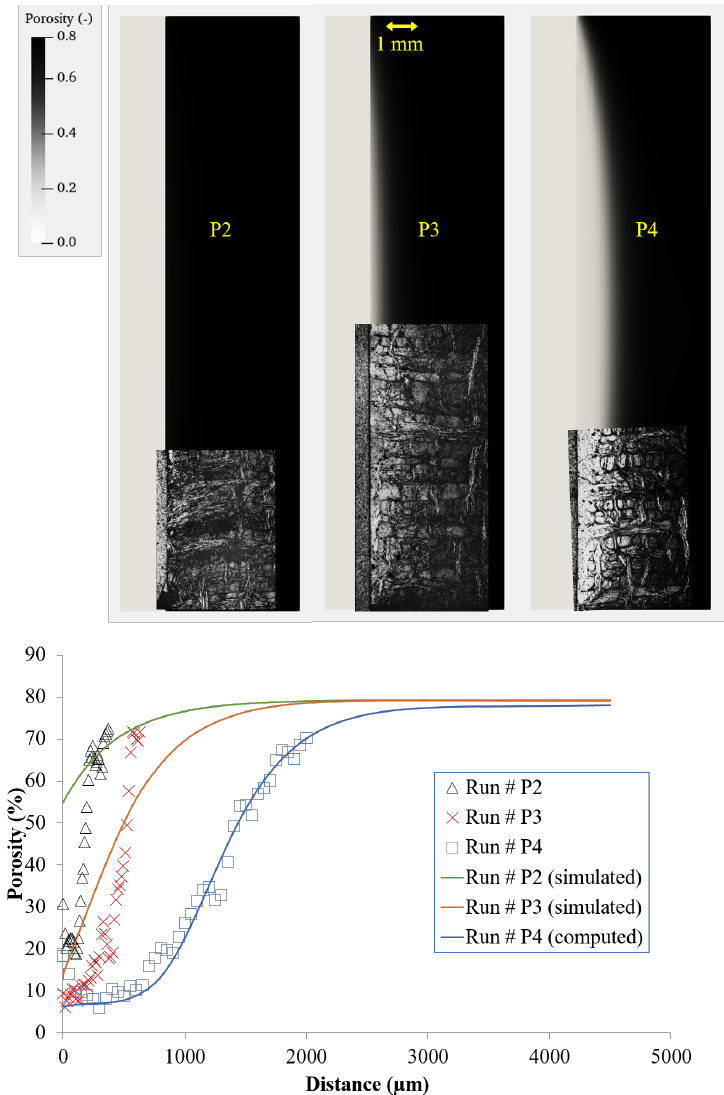
Figure 16. Simulated infiltration runs #P2–4: porosity profiles: ( top ) 2D computed profiles compared to micrographs on the same scale; ( bottom ) comparison of the porosity profiles obtained at the half-height of the